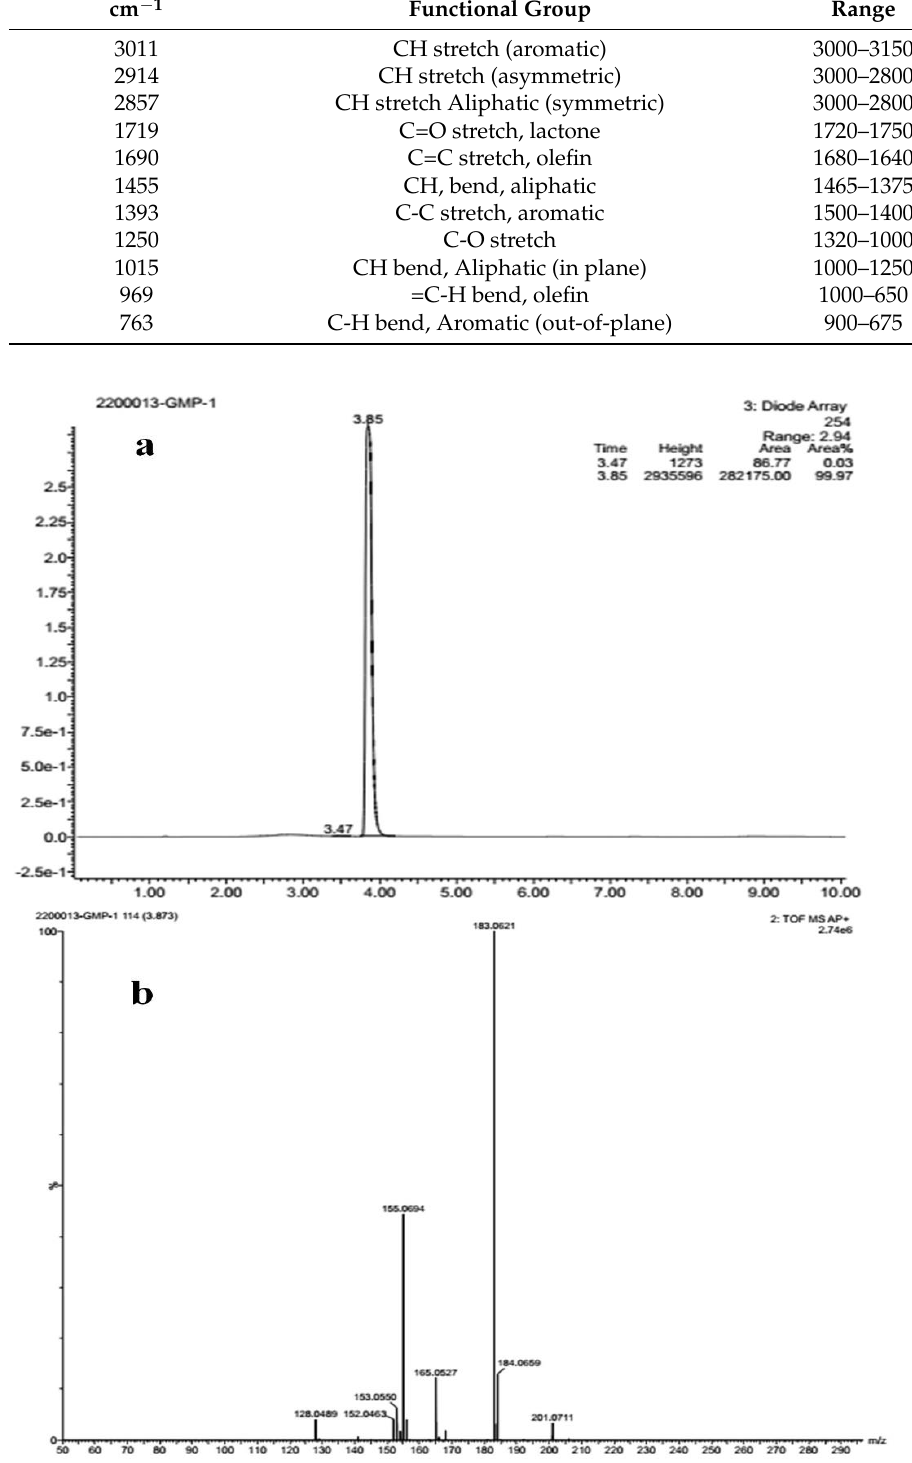
Figure 3. ( a ) Liquid chromatogram ( b ) mass spectrum studies of isolated compound.